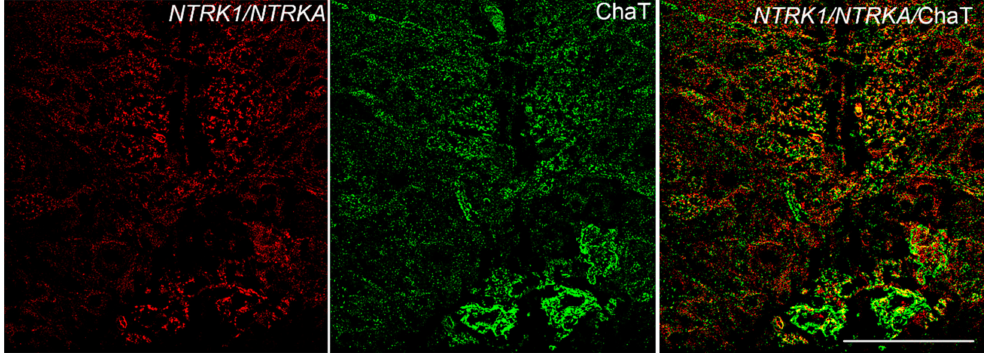
Figure 7. Transverse section of rostral reticular formation of adult N. furzeri showing staining of NTRK1 / NTRKA (red), ChaT (green) and merged. Any neuronal co-staining was observed in the merged figure, only few cholinergic fibers appeared to contact some labeled NTRK1 / NTRKA neurons. Scale bar = 50 µ